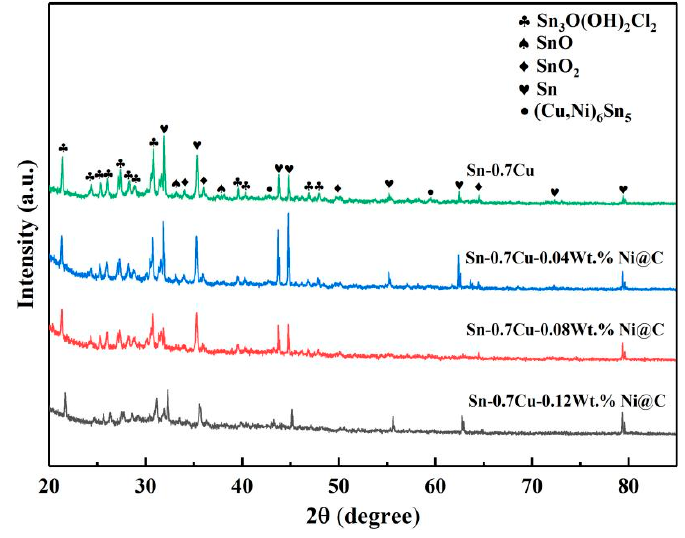
Figure 3. XRD pattern of Sn-0.7Cu- x Ni@C ( x = 0, 0.04, 0.08, 0.12 wt.%) solder after electrochemical corrosion.